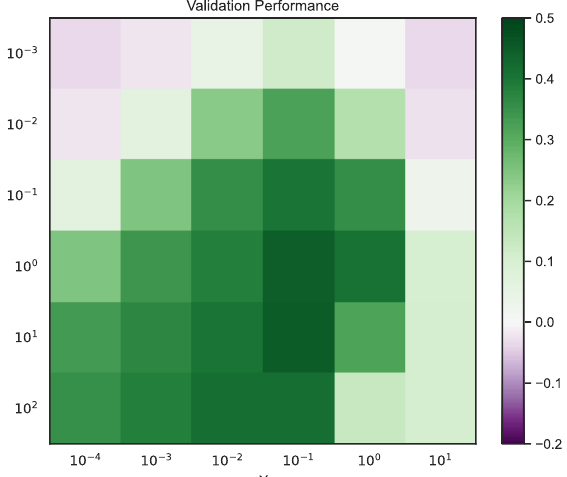
Figure 7. A coarse grid search cross-validation scheme implemented using blocked k-fold cross validation. The example shown varies both C and γ for (cid:101) = 0.4. The coarse hyper parameters are denoted by the lowest CV scores at C = 1, γ =